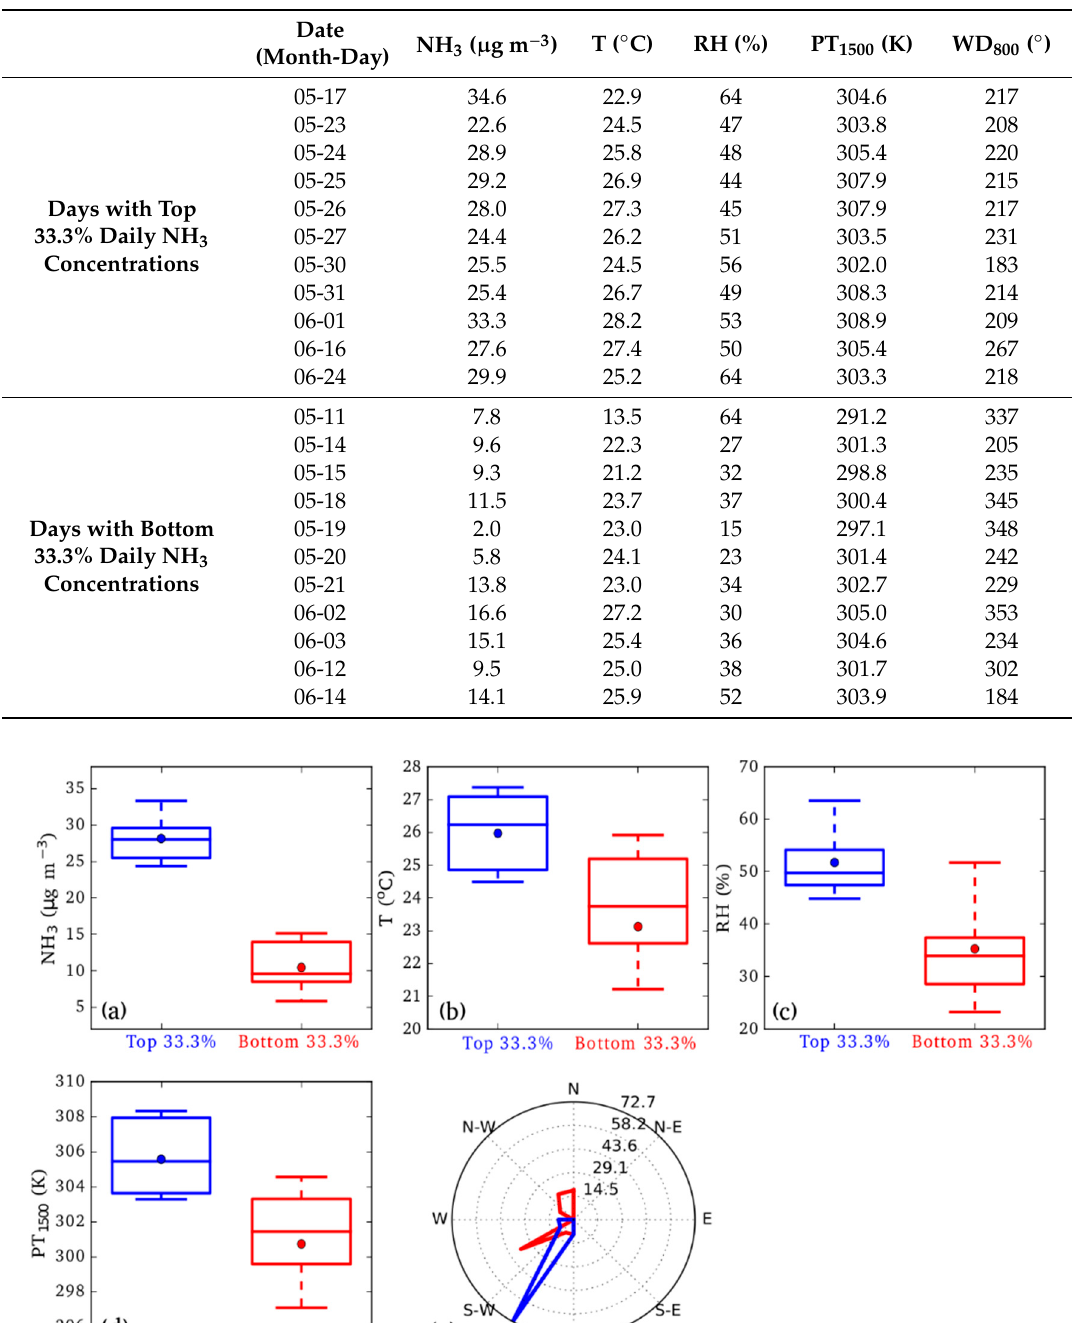
Table 1. NH 3 concentrations, 2-m T, 2-m RH, 1500-m PT and 800-m wind direction (WD) in Beijing during the dry conditions from 11 May to 24 June, 2015. Except for that the PT and WD are presented according to the soundings at 20:00 LT, the other variables are derived from the daily mean values.